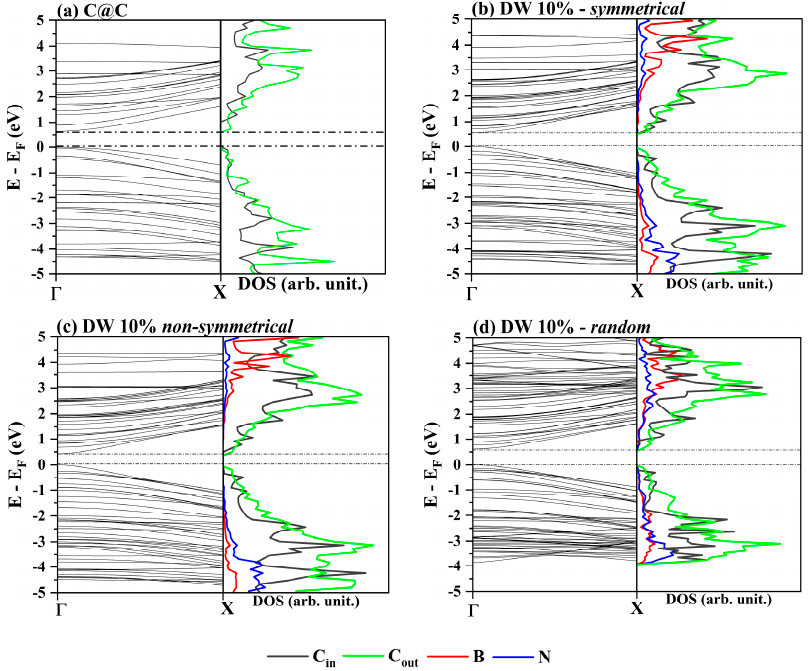
Figure 3. Band structures and DOS for zigzag nanotubes: a comparison between double-wall C@C ( a ) and the 10% doped C@(BN) 0.10 C 0.90 with different patterns, i.e., symmetrical ( b ), non–symmetrical ( c ), and random ( d ). Carbon atoms of the internal and external walls are represented by gray and green lines, respectively, while boron and nitrogen are represented by red and blue lines, respec- tively.